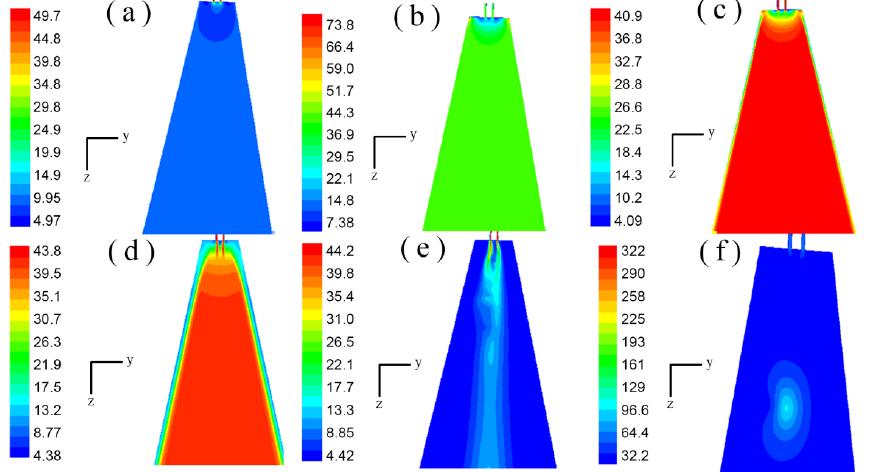
Figure 5. Velocity cloud distribution on the x–z plane (m/s): ( a ) velocity cloud distribution of flow field at time t = 1.000 × 10 − 7 s; ( b ) velocity cloud distribution of flow field at time t = 1.600 × 10 − 6 s; ( c ) velocity distribution of flow field at time t = 2.979 × 10 − 5 s; ( d ) velocity cloud distribution of flow field at time t = 1.338 × 10 − 4 s; ( e ) velocity cloud distribution of flow field at time t = 6.013 × 10 − 3 s; ( f ) velocity cloud distribution of flow field at time t = 1.543 × 10 − 2 s.